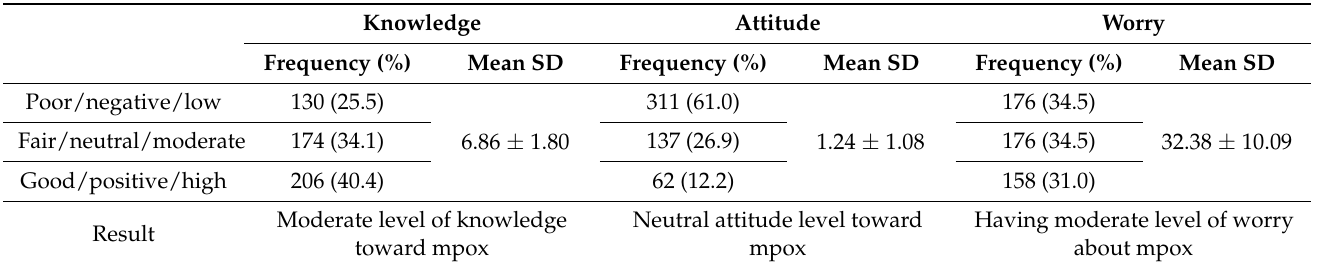
Table 3. Identifying knowledge, attitude and worry of the participants toward mpox epidemic ( n =